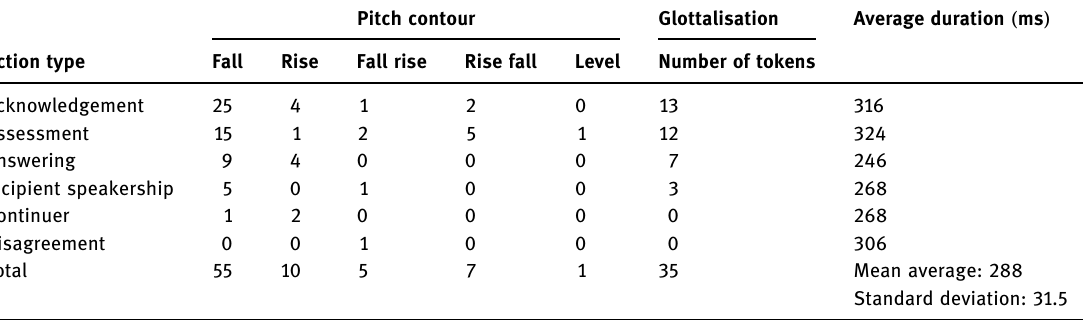
Table 2: Pitch contour, glottalisation, and average duration according to action - type classi fi cation for “ mm ” as a response token